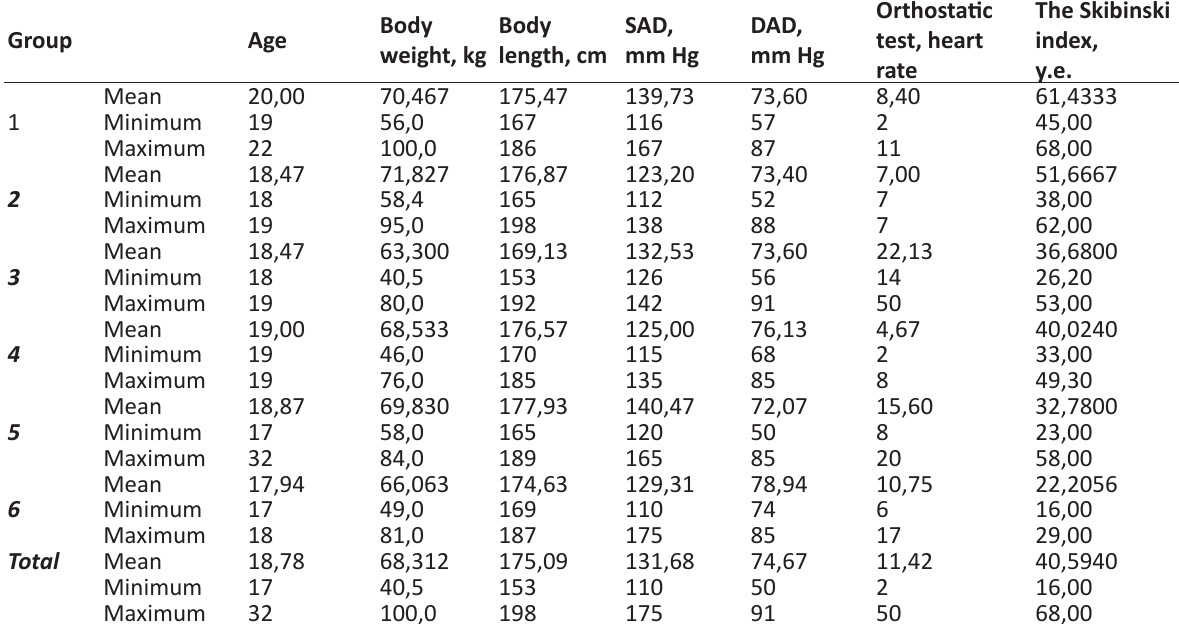
Table 9. Distribution of morphofunctional indicators